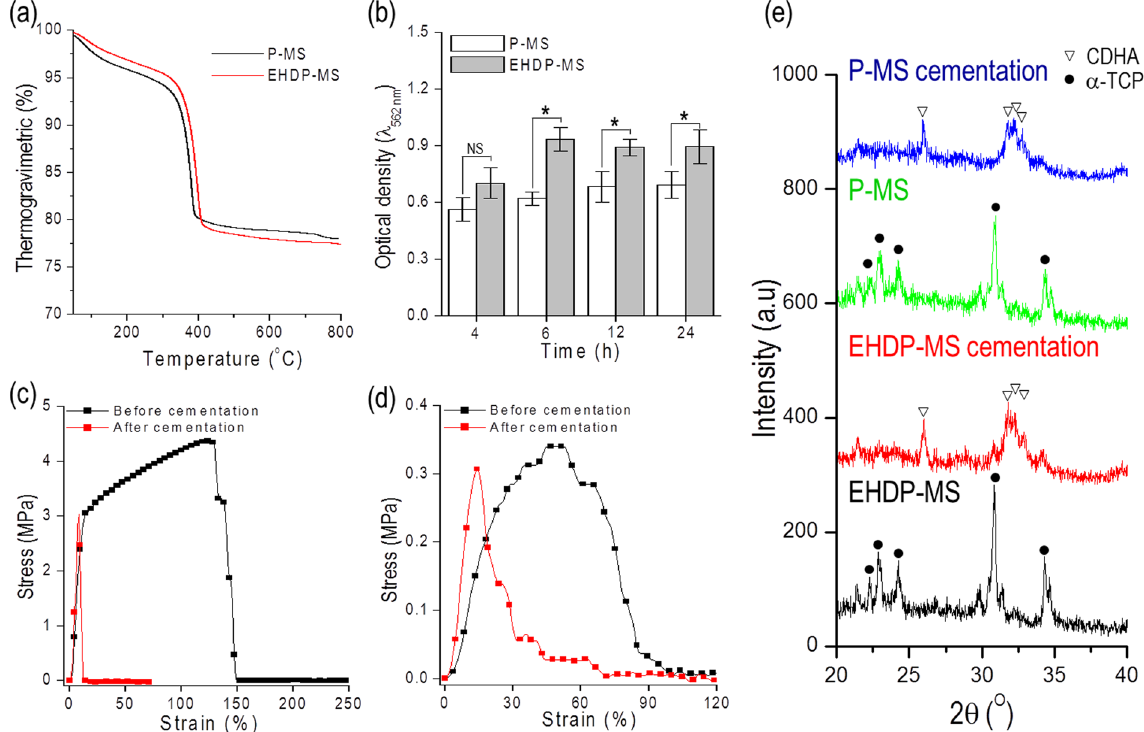
Figure 8. ( a ) Thermogravimetric analysis of P-MS and EHDP-MS, ( b ) protein absorption of P-MS and EHDP-MS, stress-strain curves of ( c ) P-MS and ( d ) EHDP-MS before and after cement reaction, and ( d ) XRD results of P-MS and EHDP-MS before and after cement